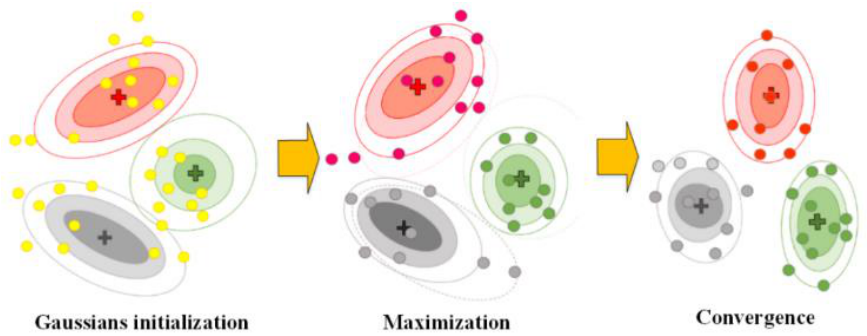
Figure 7. Illustration of Gaussian Mixture Model (GMM) based.